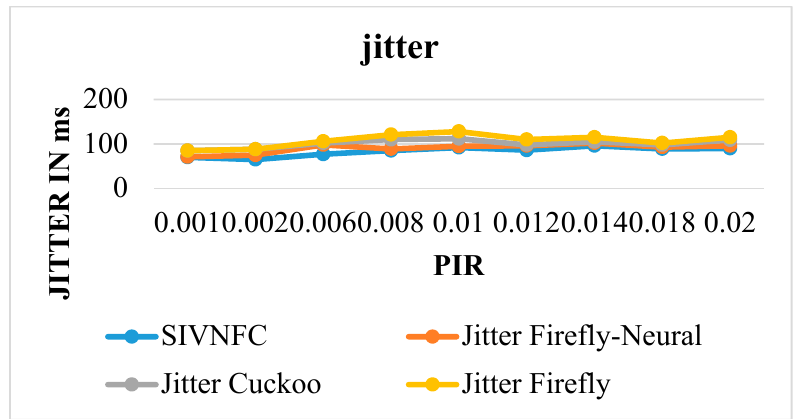
Figure 11. Jitter versus Packet Injection Rate (PIR).